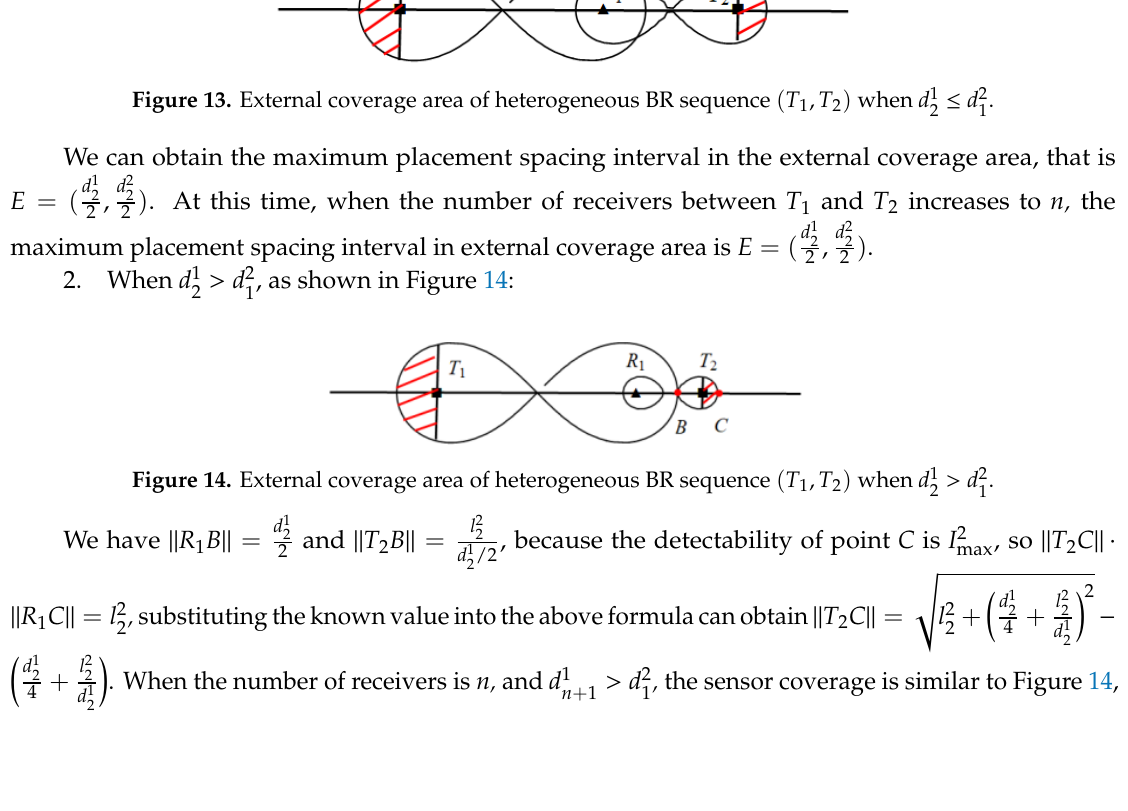
Figure 14. External coverage area of heterogeneous BR sequence 1 2 ( , ) T T when